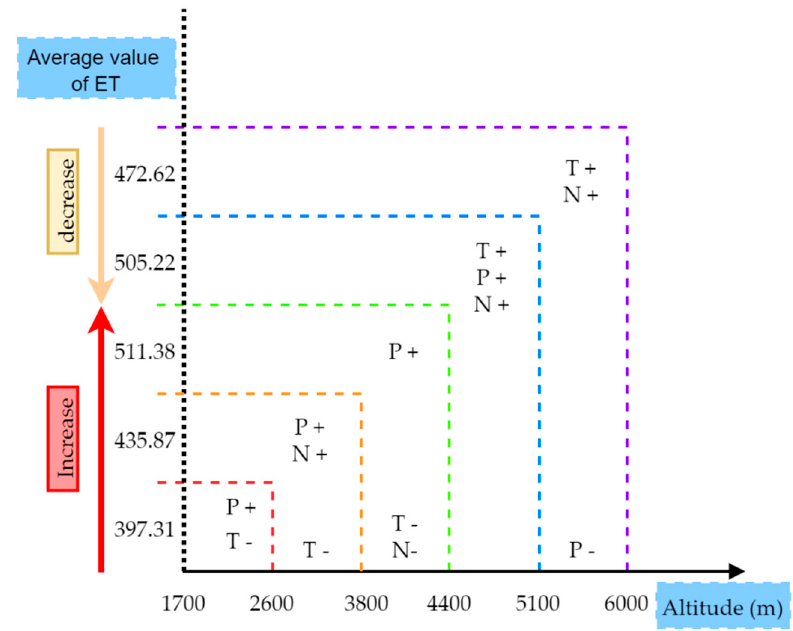
Figure 10. Diagram of influencing factors of ET in Qinghai Province. “+” “ − ” refers to the positive or negative effects of driving factors varying with altitude gradient on ET.